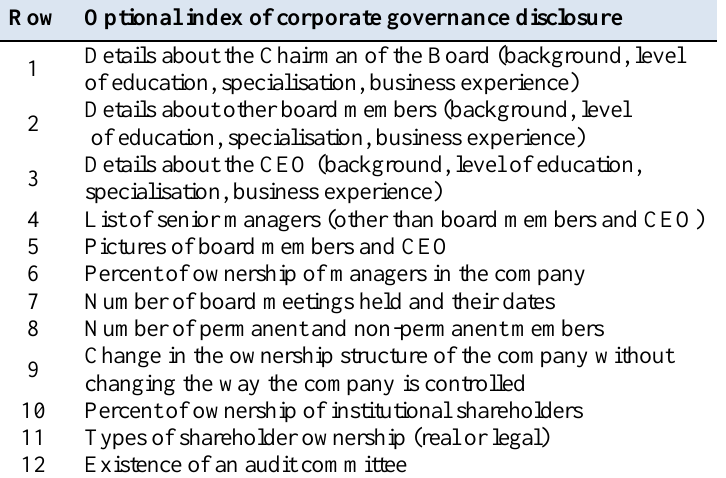
Table 1. Elements in a corporate governance disclosure